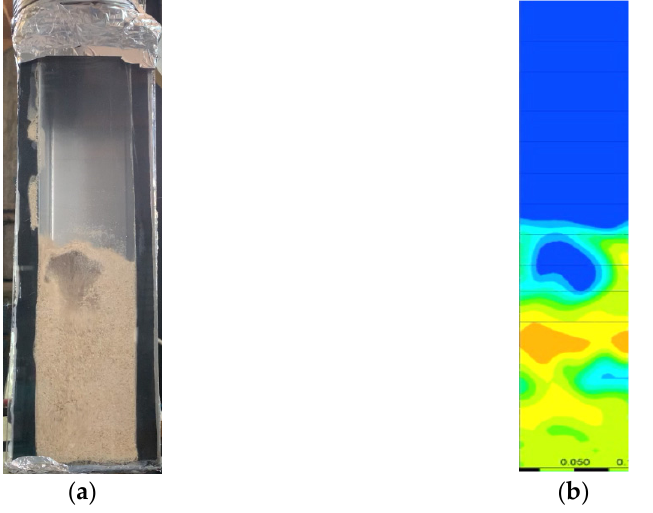
Figure 6. Typical bubble formation in ( a ) experimental and ( b ) numerical studies.